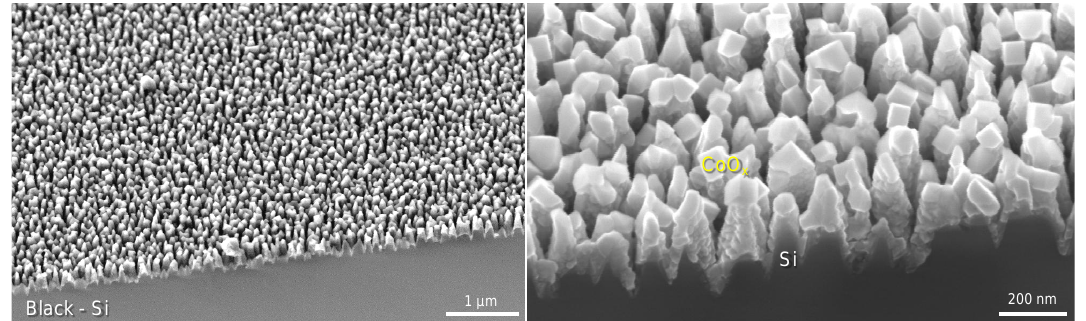
Figure 6. SEM images of as-fabricated b-Si photoanodes etched for 20 min and coated with 10 nm TiO 2 with addition of 150 nm CoO x